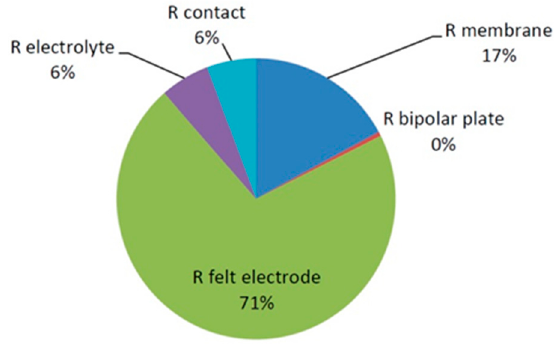
Figure 2. Distribution of ohmic resistances in a vanadium redox flow battery stack. Table 2. Output values of a 10 kW/120 kWh vanadium redox flow